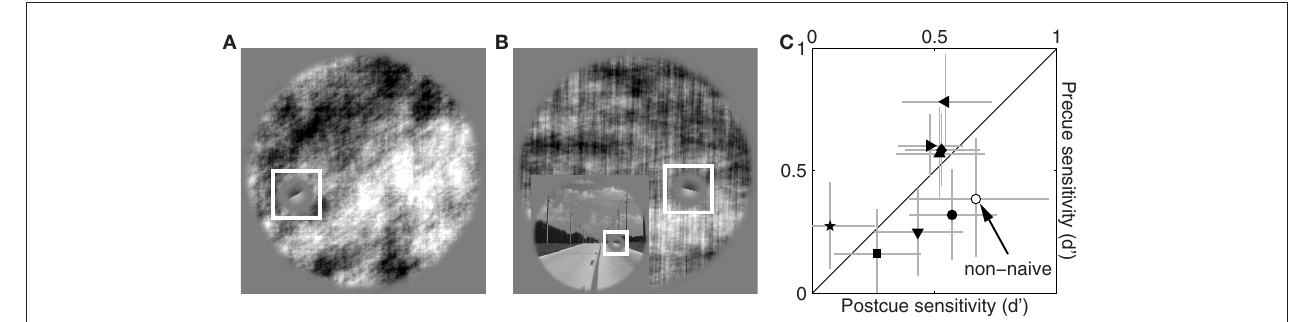
Figure 11 | Sensitivity to power-only images. (A) Shows Figure 3A following the power-only manipulation (see Section 2.1). (B) Shows another example: the original image is displayed in the inset, the power-only version in